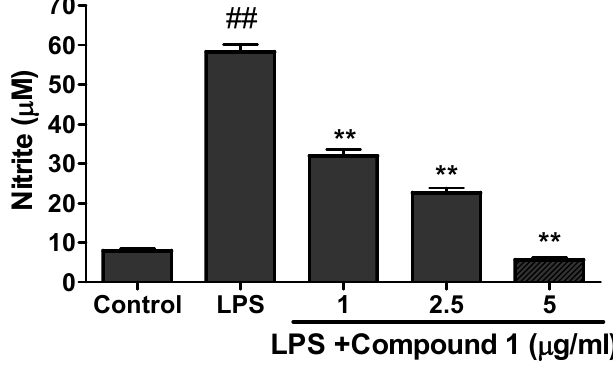
Figure 8. Production of nitrite ions after the treatment of compound 1 . RAW cells were cultured and seeded in 96-well plate. After that the cells were exposed to LPS and followed by treatment of di ff erent concentration of compound 1 . The production of nitrite ion in presence or absence of samples was evaluated using Griess reagent. The data show relative mean expression ± SD of triplicate experiments. Statistical significance was calculated using one-way ANOVA followed by Dunnett’s multiple comparisons test. ## P < 0.01 vs. Control; ** P < 0.01 vs. LPS. The anti ‐ adipogenic study confirmed that both compounds have lipid inhibiting activity in 3T3 ̵ L1 cells. ( − ) ‐ epi ‐ Osmundalactone showed higher lipid inhibiting potency than angiopteroside. The results of anti ‐ inflammatory activity on RAW cells also showed a strong activity of